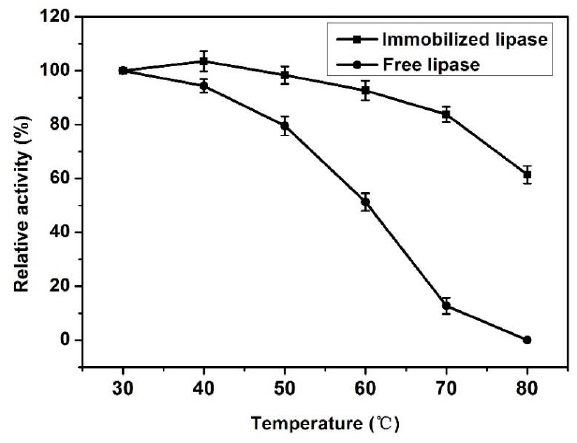
Figure 10. Thermal stability of free and immobilized lipase.